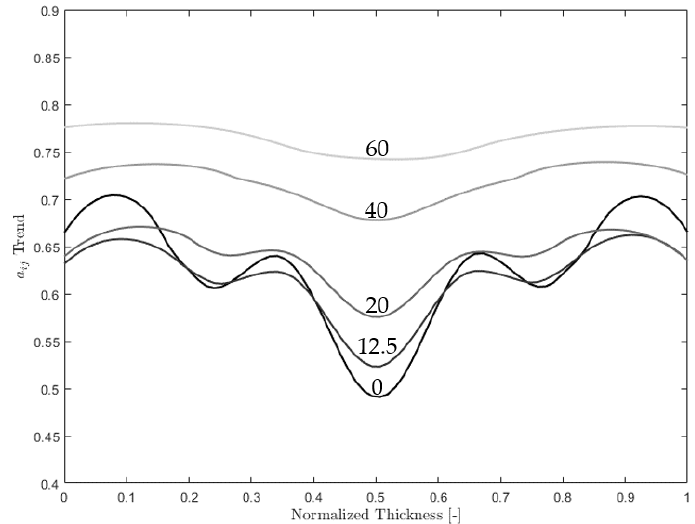
Figure 10. Smoothed computational a 11 evolution of injection molded samples at varying shear strains.